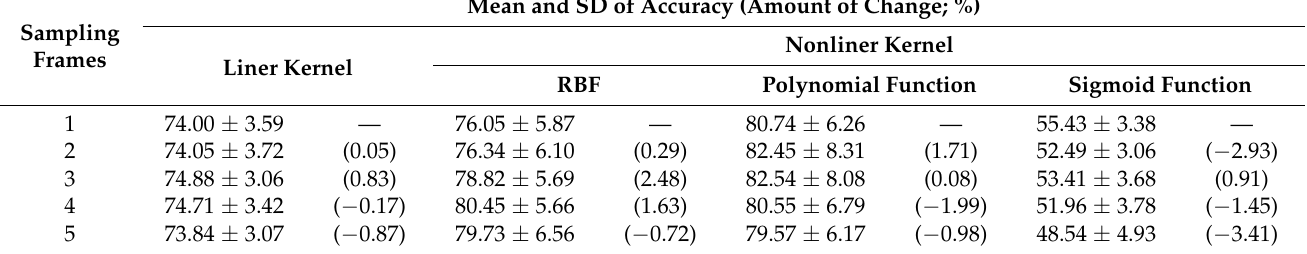
Table 2. Comparison of sampling frames (mean and SD) of classification accuracy in one linear kernel and three nonlinear kernels a .